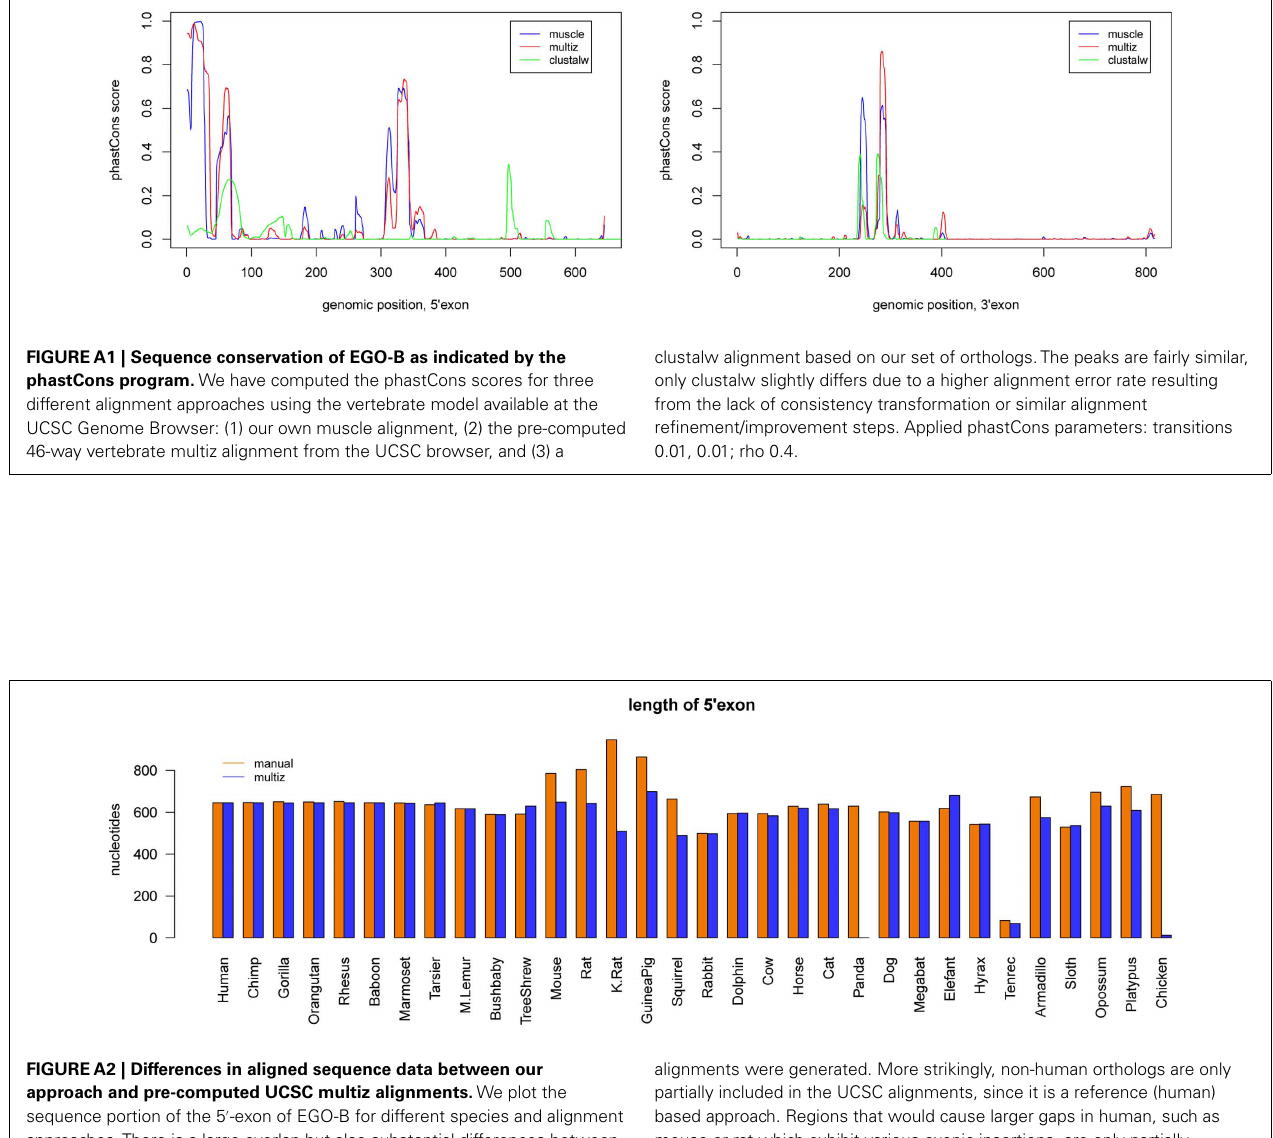
alignments were generated. More strikingly, non-human orthologs are only partially included in the UCSC alignments, since it is a reference (human) based approach. Regions that would cause larger gaps in human, such as mouse or rat which exhibit various exonic insertions, are only partially included in the final alignment. However, partial sequences are crucial for any subsequent analysis relying on valid alignments, i.e., RNA secondary structure